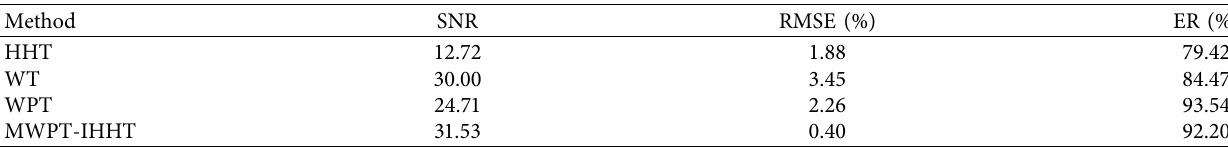
Figure 8: Time-frequency comparison of the MWPT-IHHTand three commonly used denoising methods. (a) Original synthetic signal. (b) HHT. (c) WT. (d) WPT. (e) MWPT-IHHT. Table 1: Quantitative comparison of four denoising